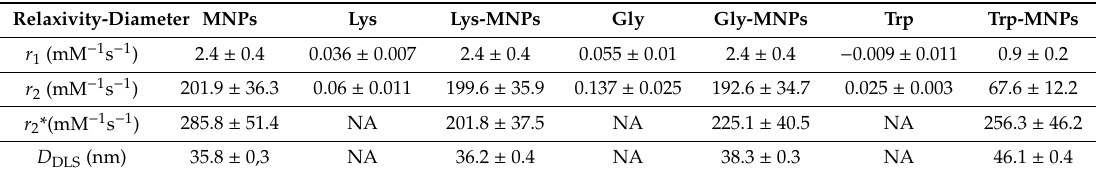
Table 3. Relaxivity values of MNP complexes with and without AA coating (Lys, Gly, Trp). Hydrodynamic diameter of complexes obtained by the DLS technique. (Please see Supplementary Material how relaxivities were determined.)